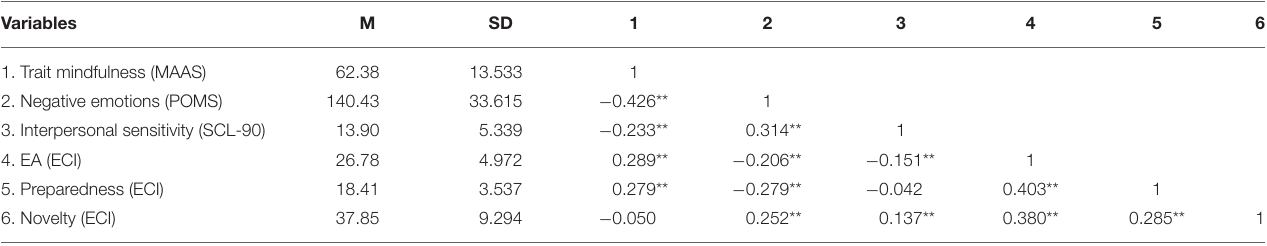
TABLE 1 | Descriptive statistics and related analysis results of variables. Variables